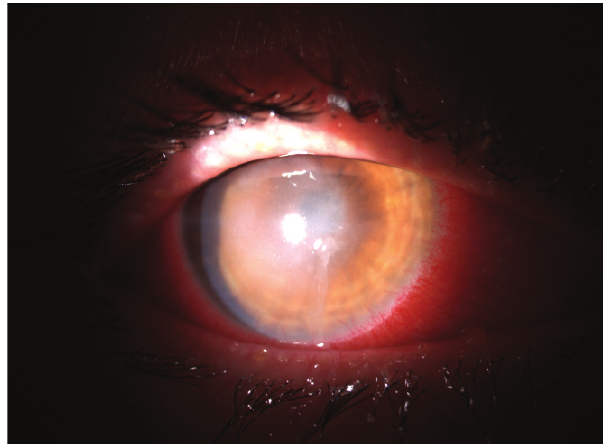
Figure 1 - Central corneal keratitis in the right